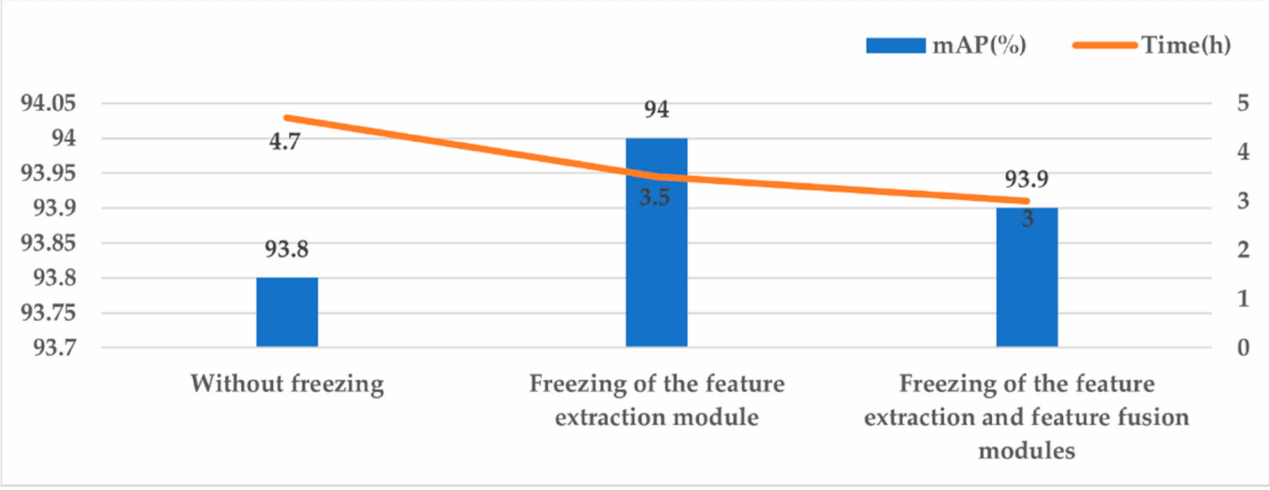
Figure 19. The results of multi-stage transfer learning